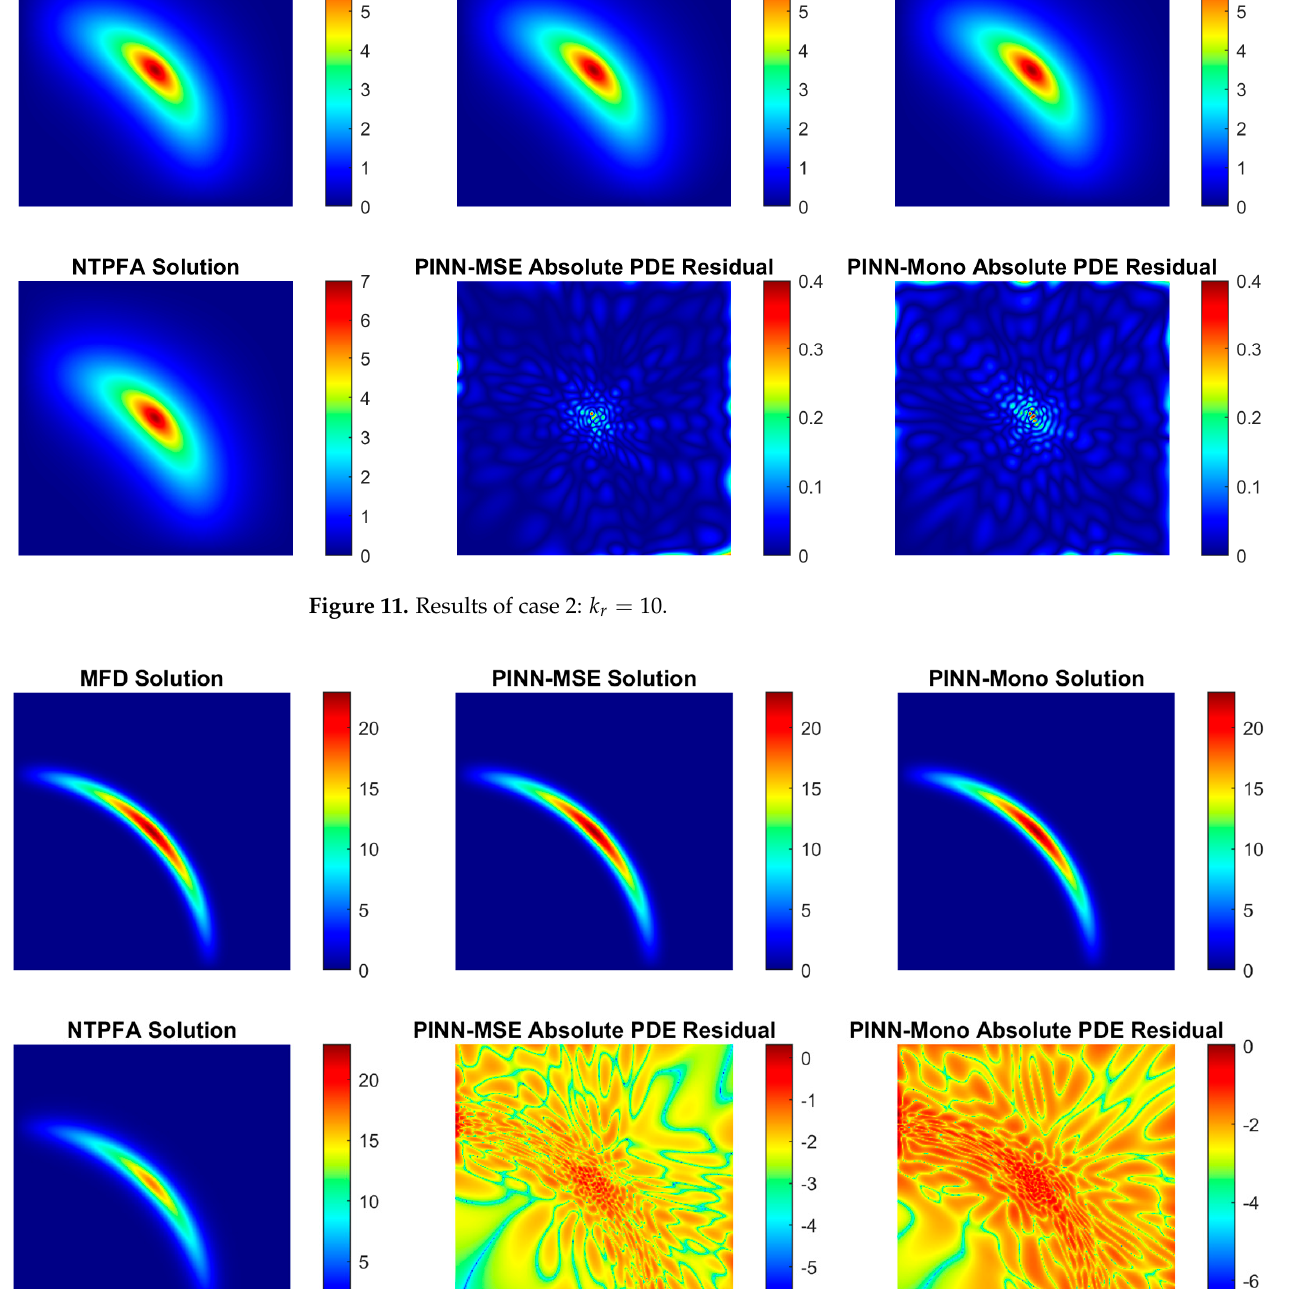
Figure 12. Results of case 2: 𝑘 (cid:3045) = 1000 . The absolute PDE residuals shown in the second row are in log-scale.